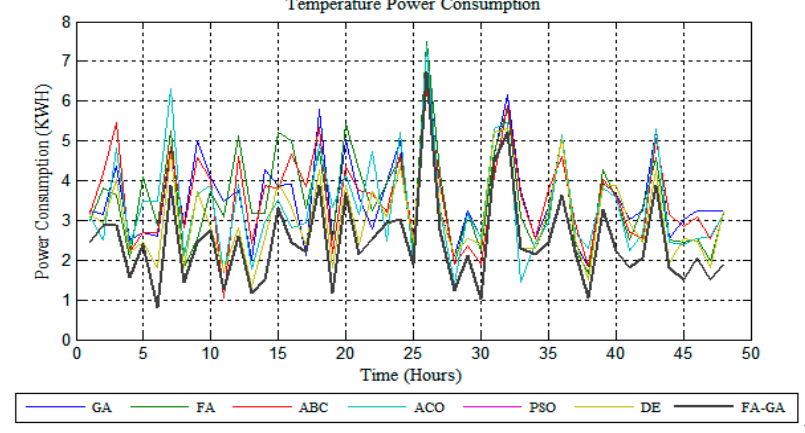
Figure 3. Temperature power consumption based on the considered approaches.